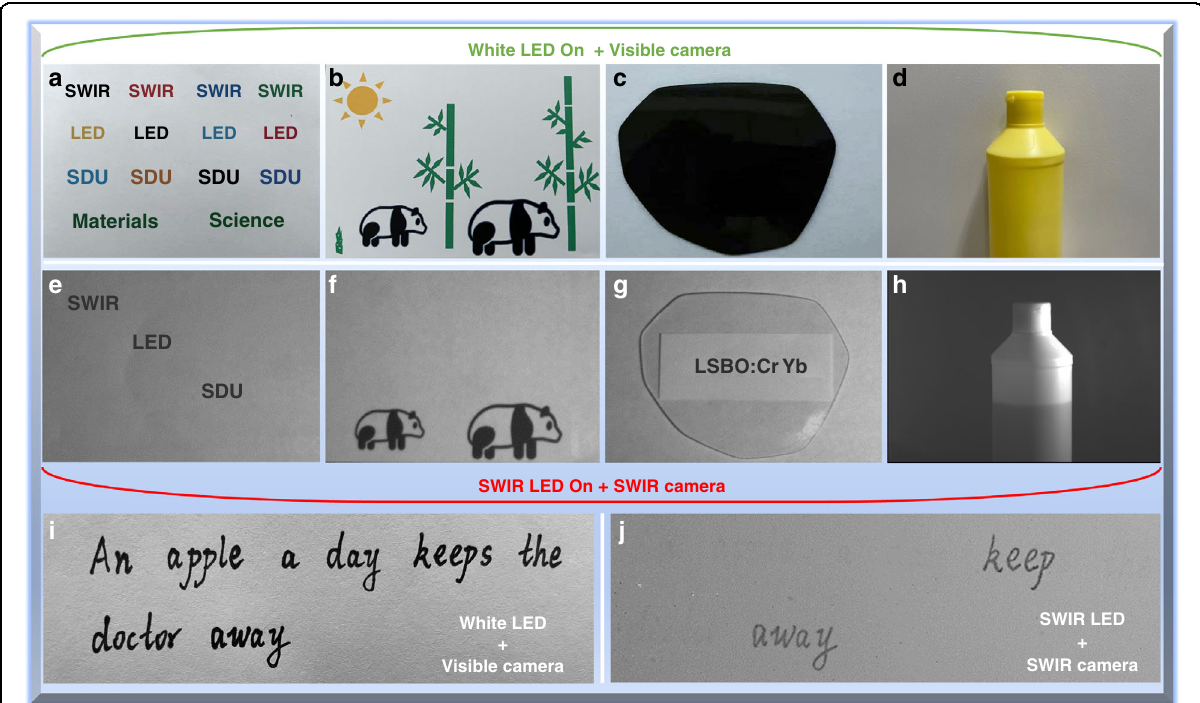
Fig. 6 Applications based on the SWIR LED prototype device. a – d Visible images taken with a standard digital camera when illuminated with white LED. e – h SWIR images taken with an InGaAs SWIR camera when the SWIR LED is turned on. i , j Photographs of a short message written by black carbon pen and black watercolor pen when illuminated with white LED and SWIR LED,